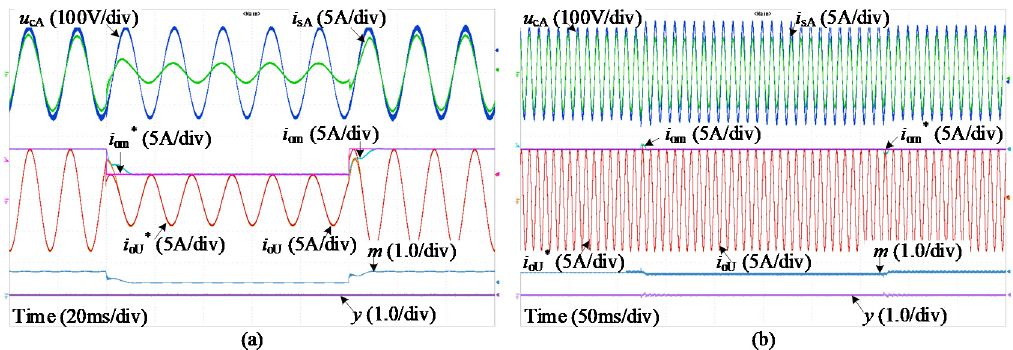
Figure 10. Experimental results with the proposed modulation scheme and feedback control strategy during the dynamic process: ( a ) the reference amplitude, i om* , of output current fluctuates between 8 A and 4 A; ( b ) the amplitude of source voltages is increased by 10% and then returns to the normal.